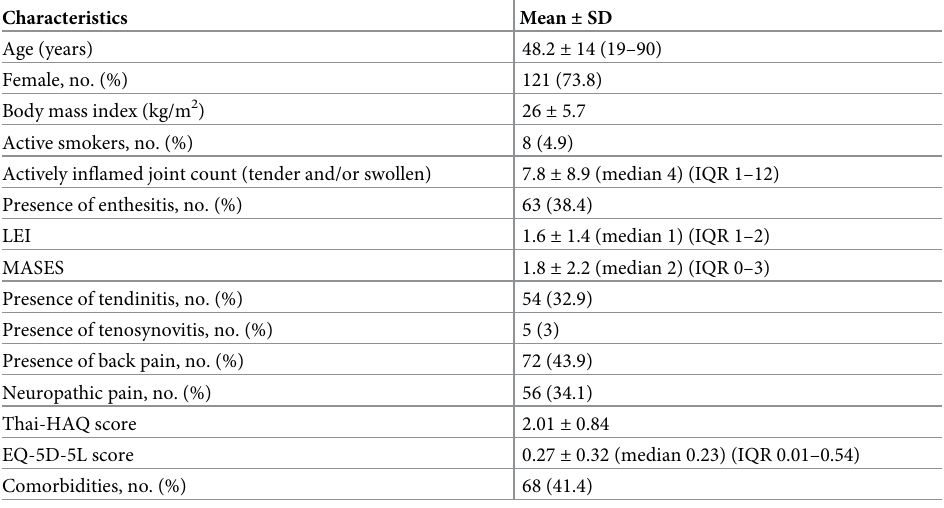
Table 1. The baseline characteristics of participants with rheumatic manifestations resulting from Chikungunya virus infection at the rheumatologist’s first assessment (n = 164).